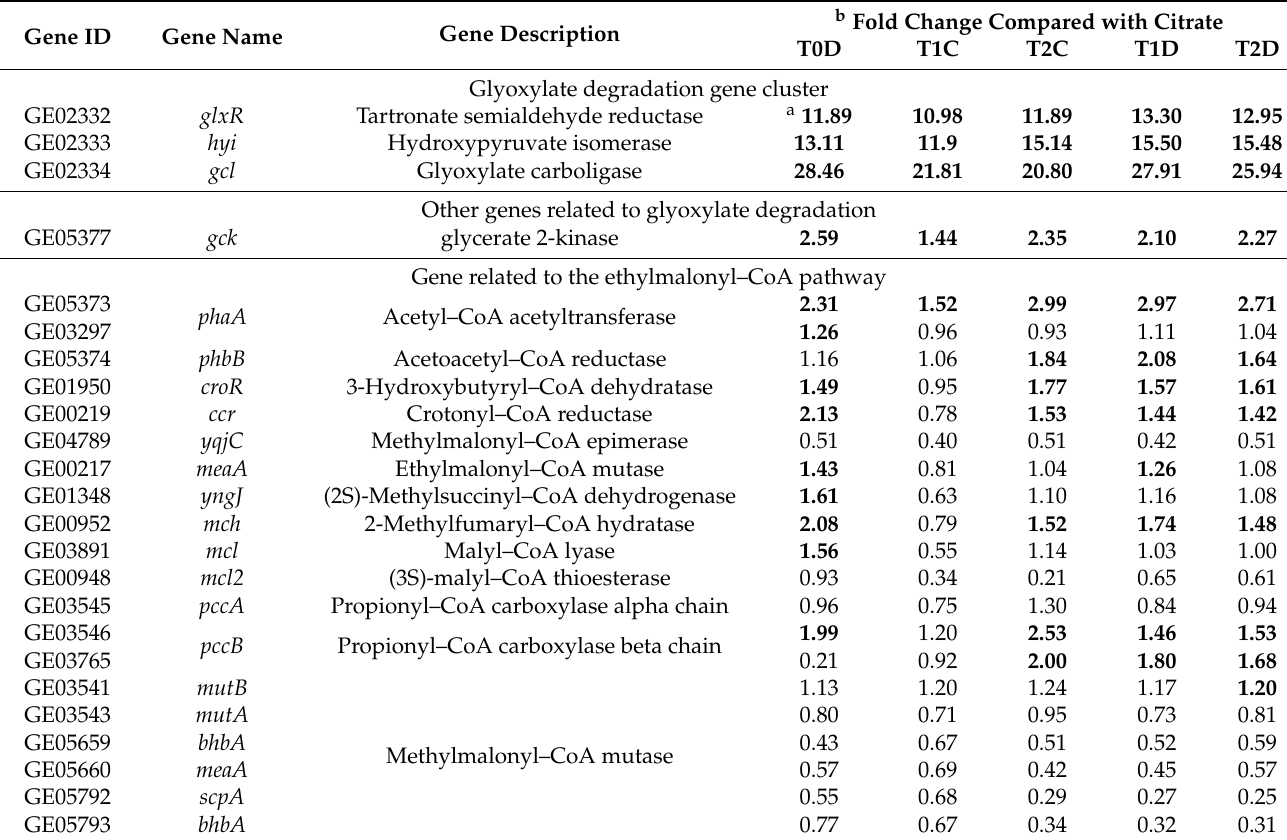
Table 3. Genes related to the metabolism of